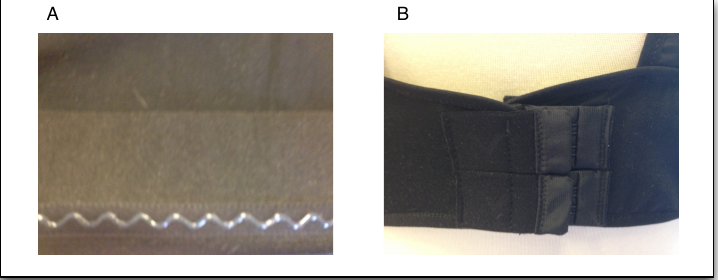
Figure 3. Vest: ( A ) anti-slip band; ( B ) adjustable fastener.